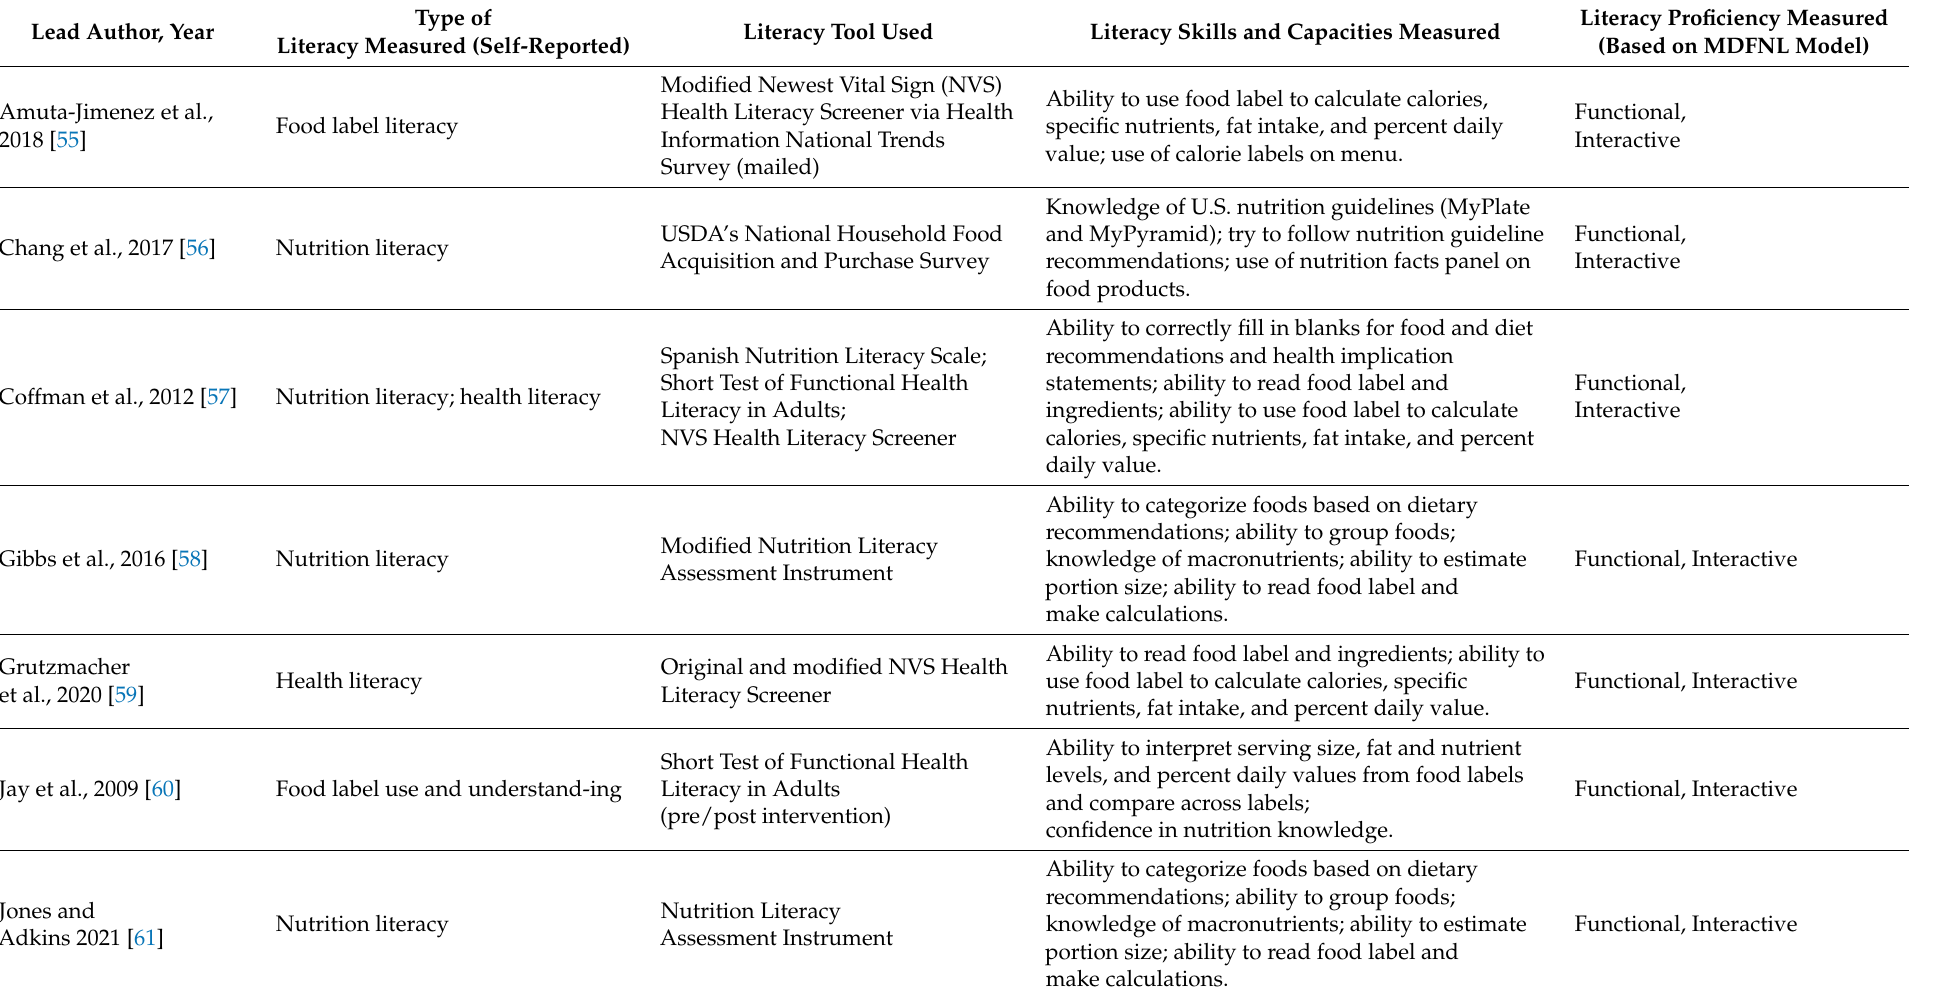
Table 3. Literacy measurements and tools used in the 18 studies